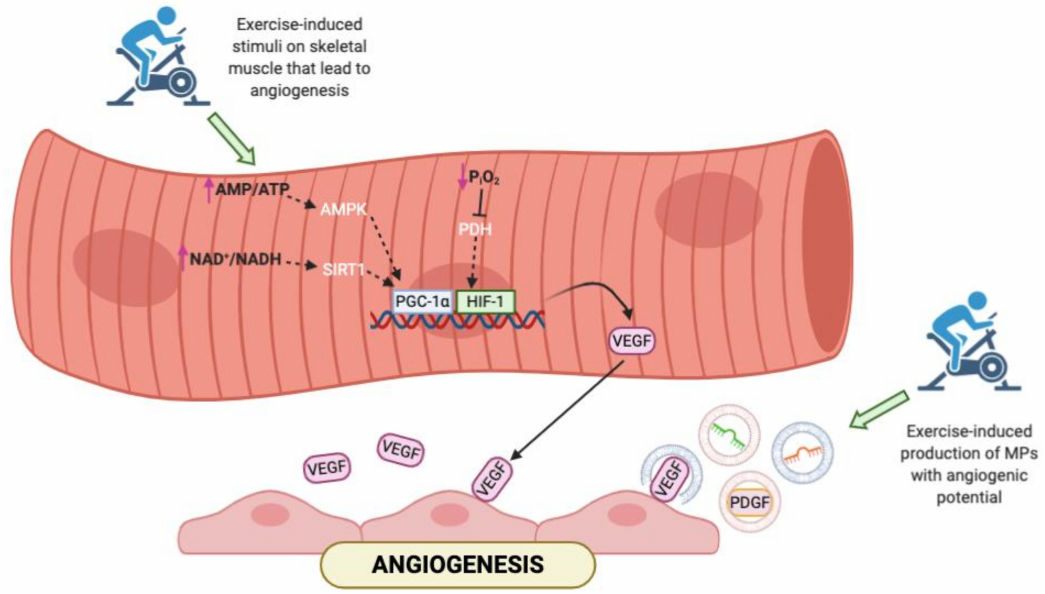
Figure 1. Representation of the main pathways activated in skeletal muscle in response to exercise. In addition to the canonical molecular pathways, aerobic exercise may a ff ect the release of microparticles (MPs) that carry soluble factors involved in angiogenesis. AMP = adenosine monophosphate; ATP = adenosine triphosphate; NAD = nicotinamide adenine dinucleotide; NADH = reduced nicotinamide adenine dinucleotide; PGC-1 α = peroxisome proliferator-activated receptor gamma coactivator 1-alpha; HIF = hypoxia-inducible factor; VEGF = vascular endothelial growth factor; PDGF = platelet-derived growth